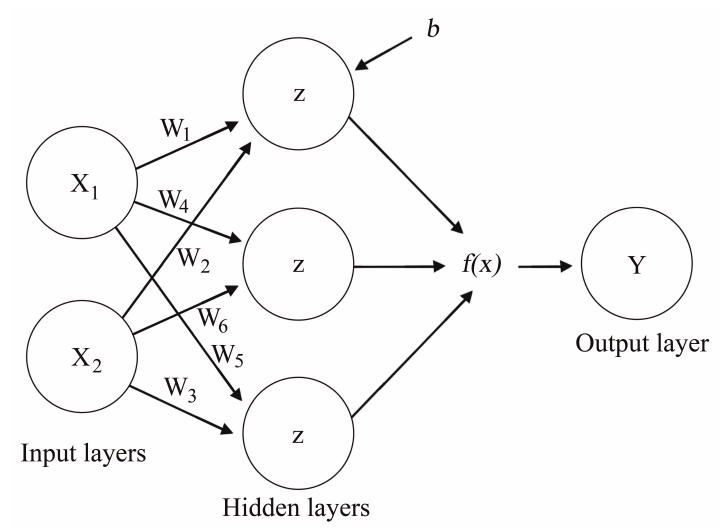
Figure 1. Representation of an artificial neural